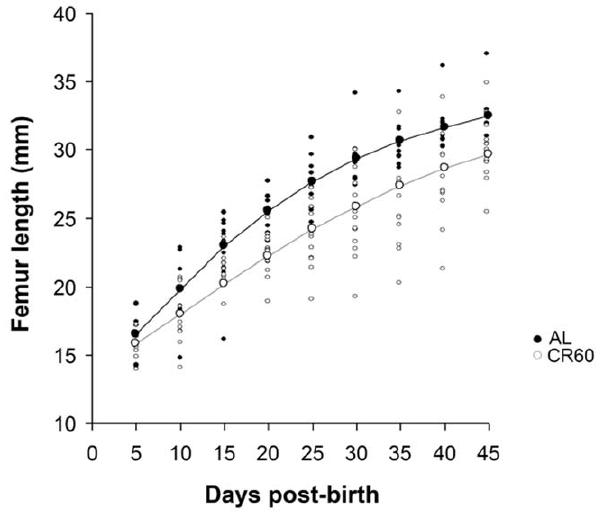
Figure 2. Effect of food availability to lactating mothers on offspring femur growth. Femur length grew slower and less for pups reared by calorie restricted females (CR60, open circles, grey line) than for those reared by females fed ad libitum (AL, black dots, black line). Lines draw the growth curves estimated per treatment with 2- parameters Gompertz